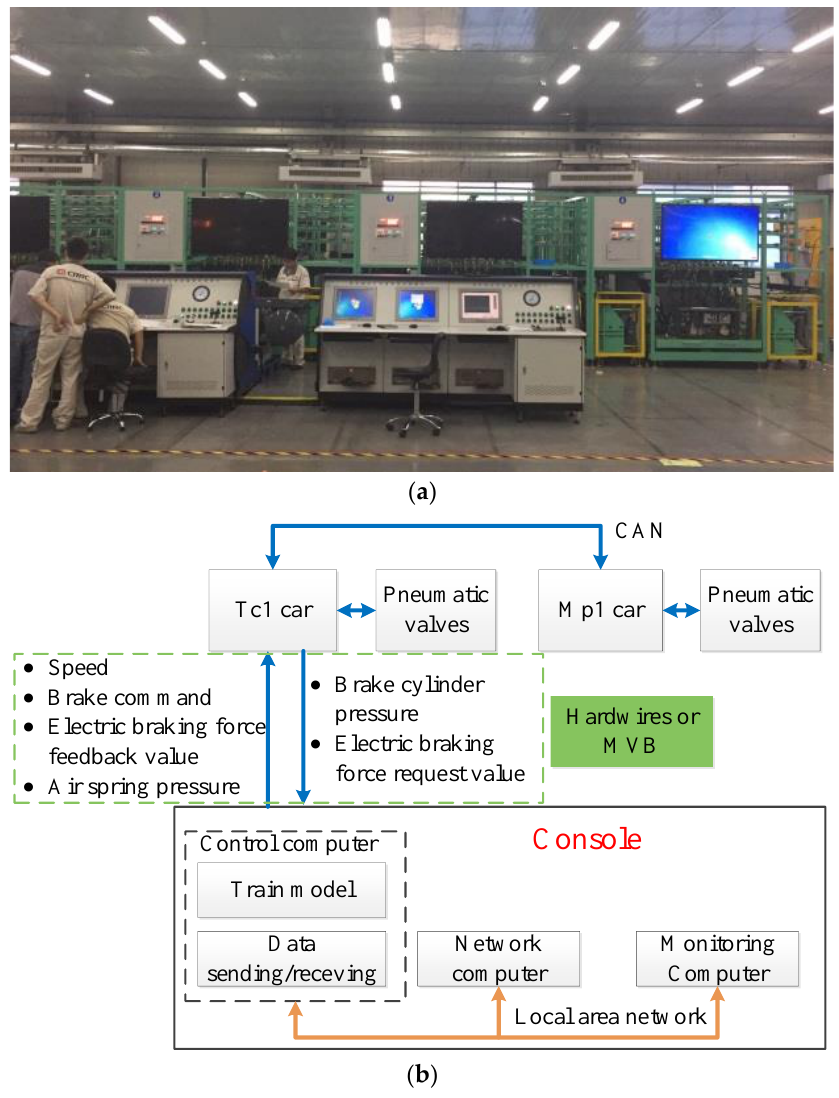
Figure 6. Ground-combined test bench: ( a ) photograph; ( b ) schematic diagram.